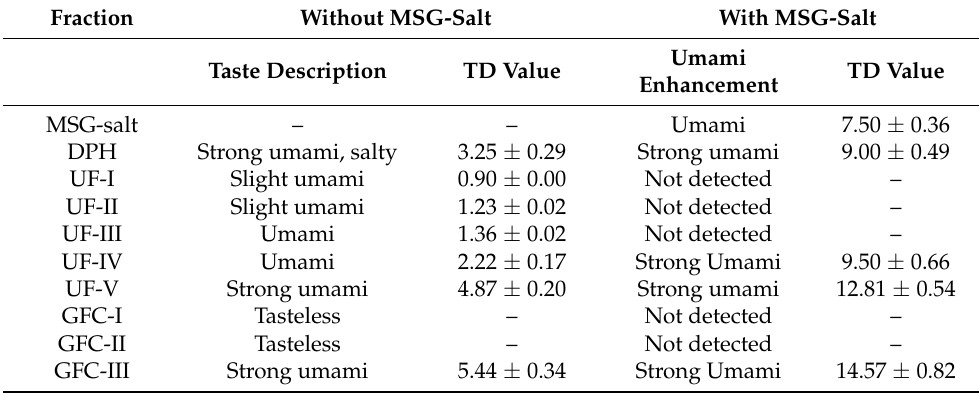
Table 3. Sensory evaluation of UF and GFC